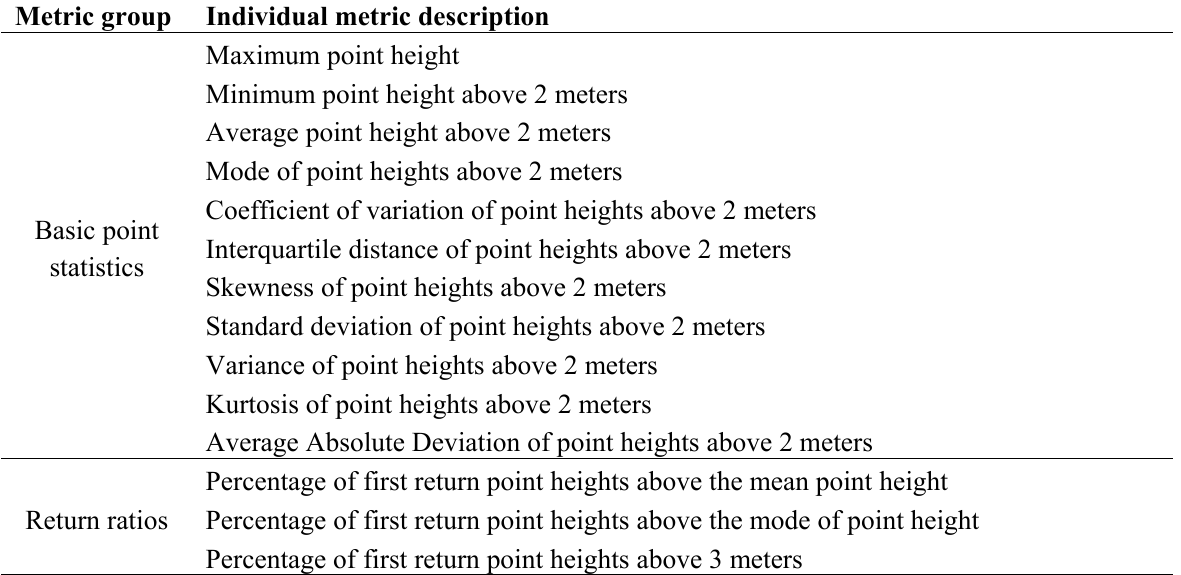
Table A1. Description of the 53 LiDAR-derived metrics used as explanatory variables for the classification tree analysis. All metrics were calculated on a 30 m raster grid using FUSION